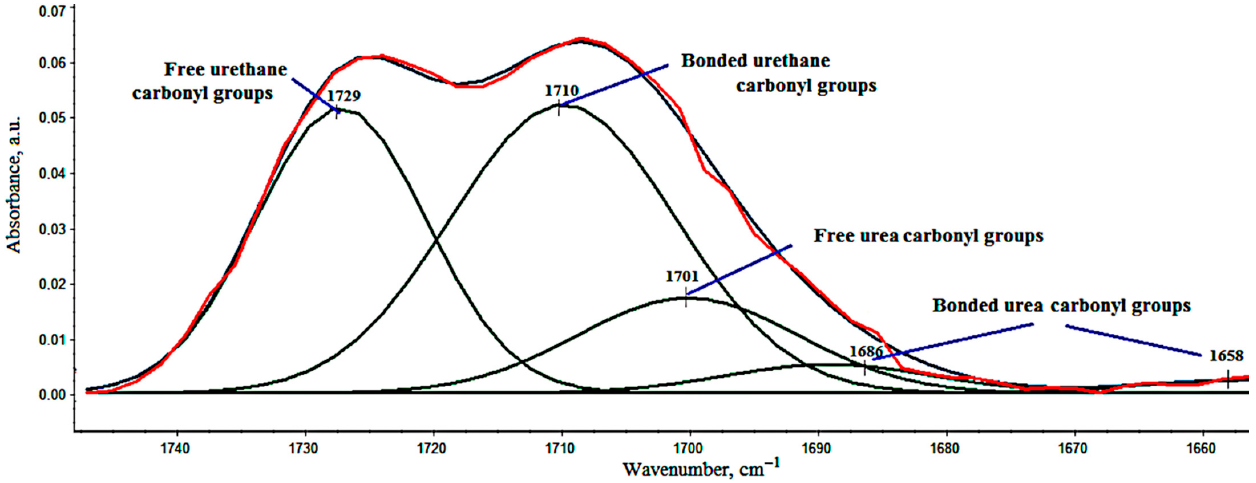
Figure 4. Region of C=O of FT-IR spectra of VEFL15 after decomposition in Gaussians.